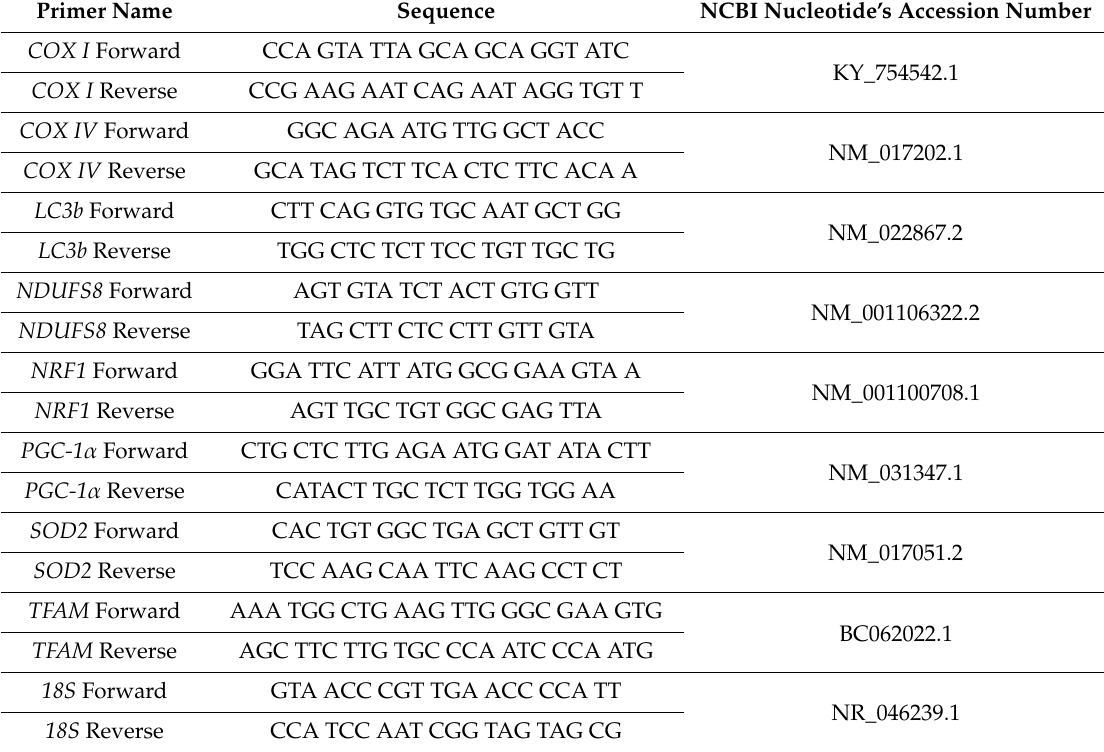
Table 1. qPCR primers